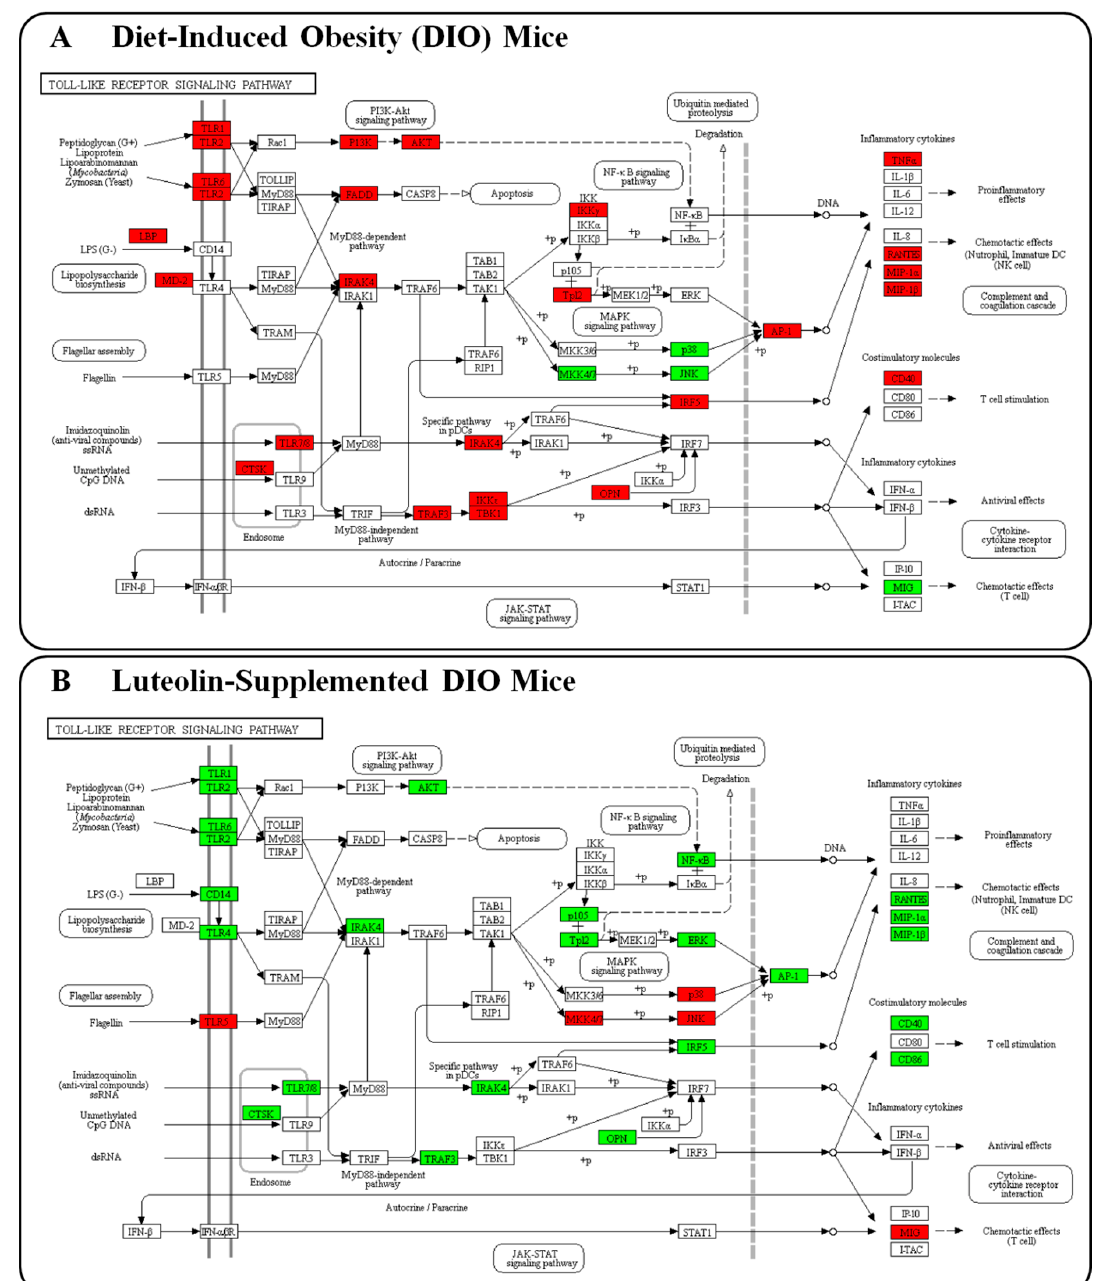
Figure 5. Gene transcription pattern related to the TLR signaling pathway in white adipose tissue. Symbols in red were up-regulated while those in green were down-regulated. ( A ) Gene expression levels altered by the HFD. ( B ) Gene expression levels altered by luteolin treatment.